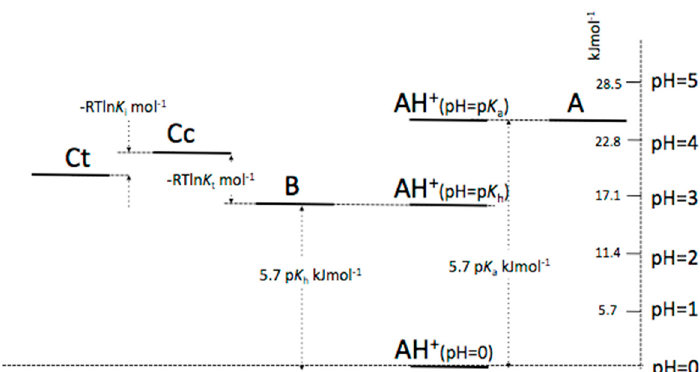
Scheme A6. Energy level diagram for a hypothetical flavylium multistate.